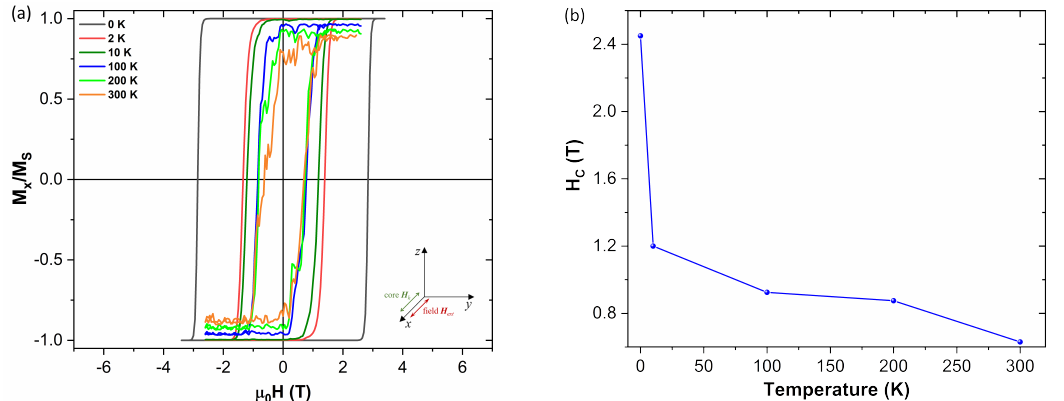
Figure 8. ( a ) Magnetic isotherm when applying the external magnetic field ( H ext ) parallel to the anisotropy axis ( H k along the x-axis) of the NP (of core size 5.5 nm and 0.5 nm shell thickness). ( b ) Plot of the coercivity ( H c ) versus temperature, showing how it rapidly decreases due to the presence of the thermal field.